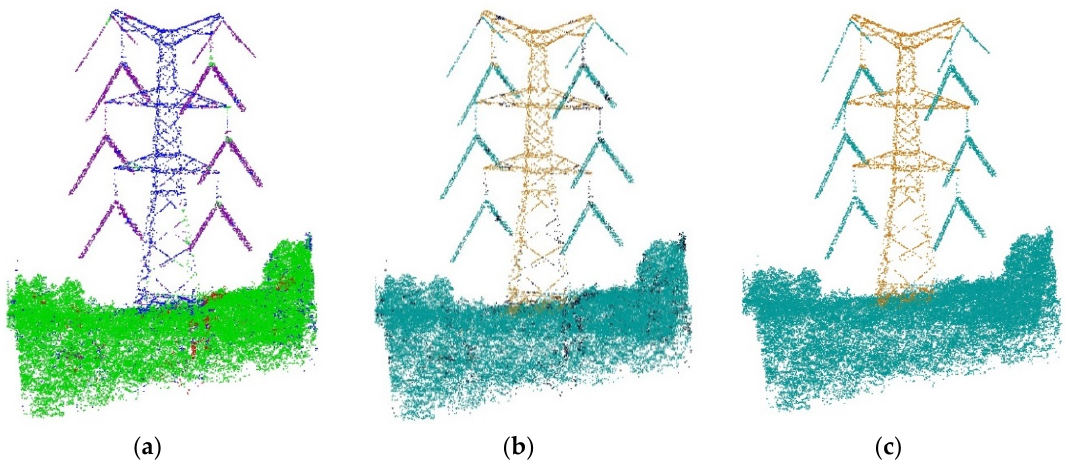
Figure 4. Foreground/background segmentation for a pylon neighborhood: ( a ) initial classification using the JointBoost classifier and local features (color legend: buildings/red, trees/green, power lines/violet, pylons/blue); ( b ) foreground and background seed points, with the foreground seed points shown in orange, the background seed points shown in blue, and the points of unreliable objects shown in black; and ( c ) the foreground and background segmentation results.